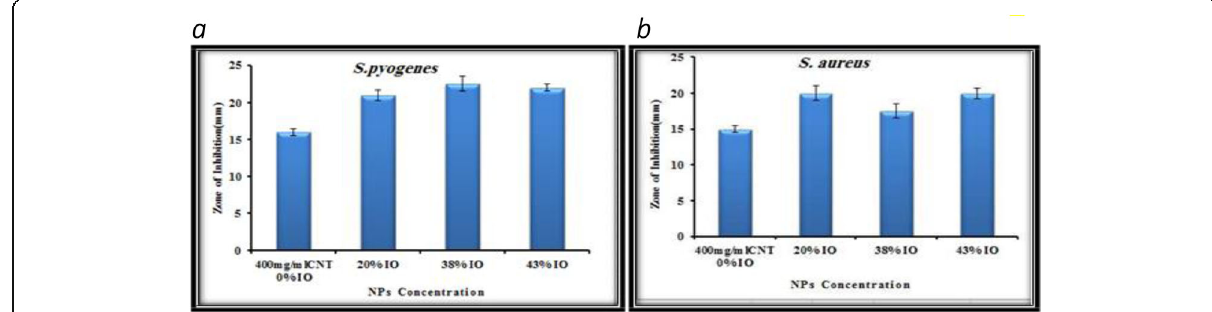
Fig. 6 Images and histograms of Anti-bacterial growth reduced by IO-MWCNTs and composite that ’ s dubbing IO-MWCNTs NPs against two gram-positive ( a ) S. pyogenes and ( b ) Staphylococcus aureus ( S. aureus